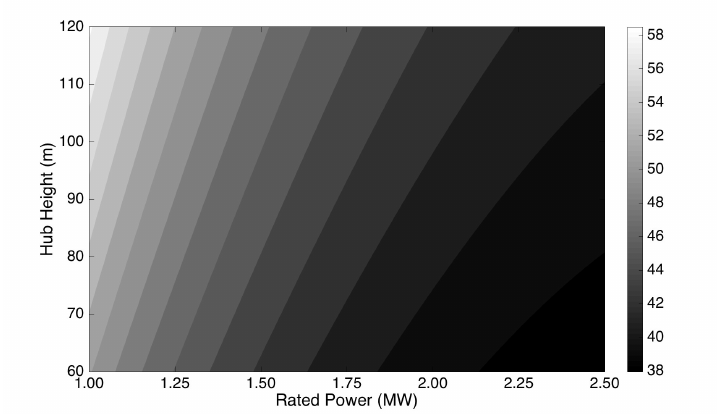
Figure 20. Variation of the average annual cost (in $/kW installed) of wind farms with respect to the hub height and rated power of turbines, assuming a 70 m rotor